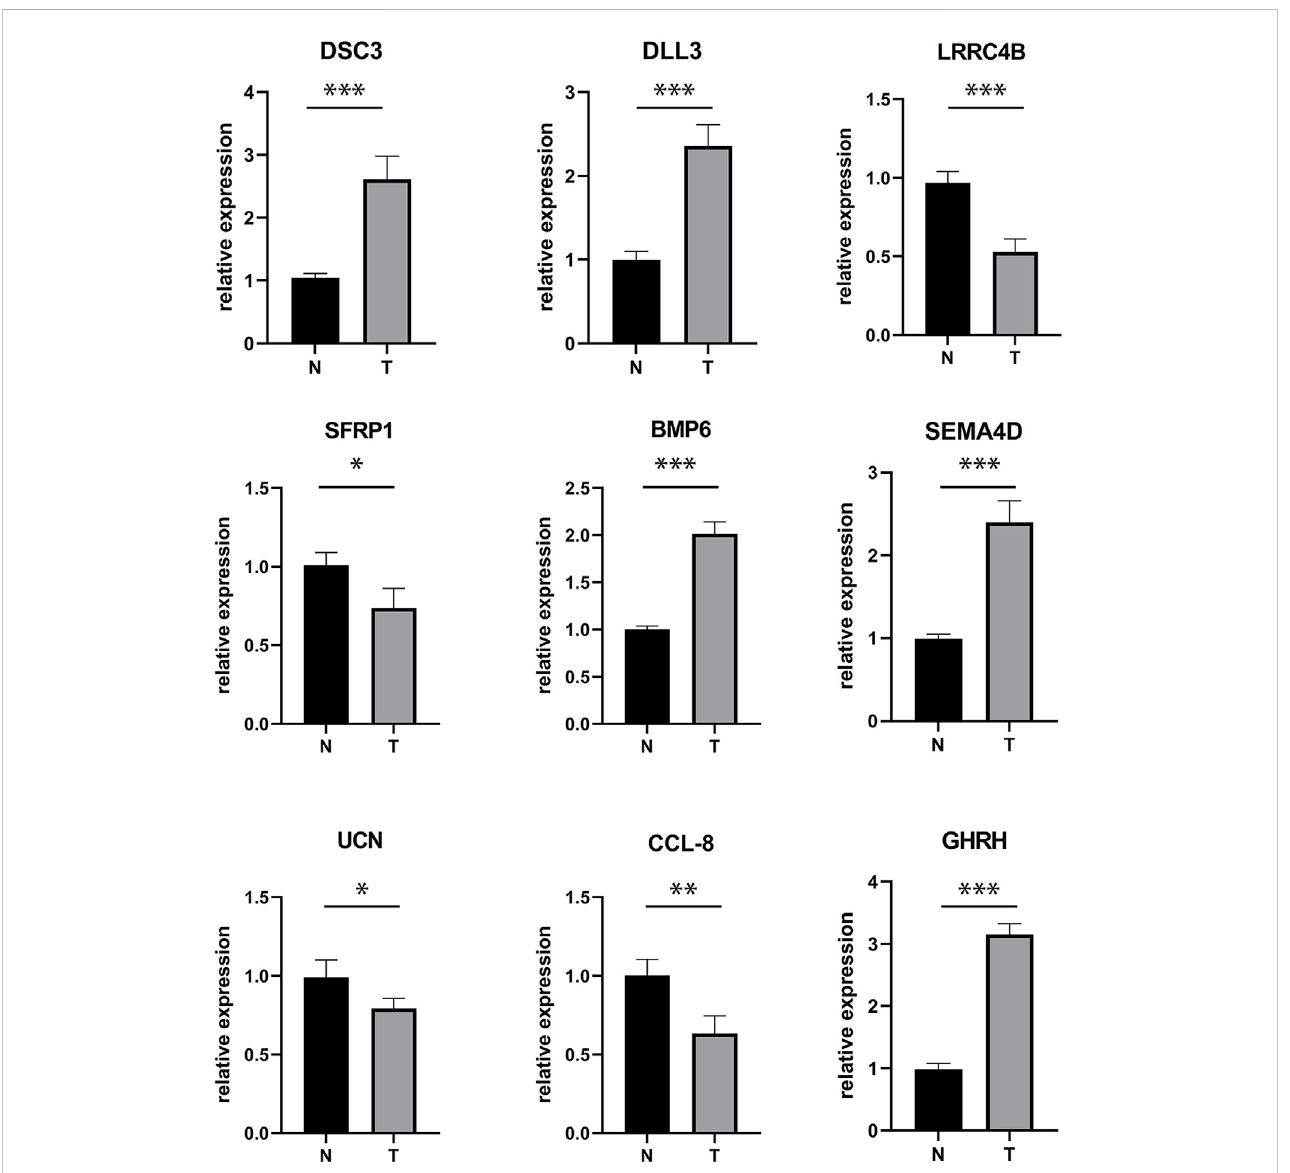
FIGURE 12 The mRNA expression of LR pairs-related genes in melanoma. N-normal, T-tumor (* p < 0.05, ** p < 0.01, *** p <